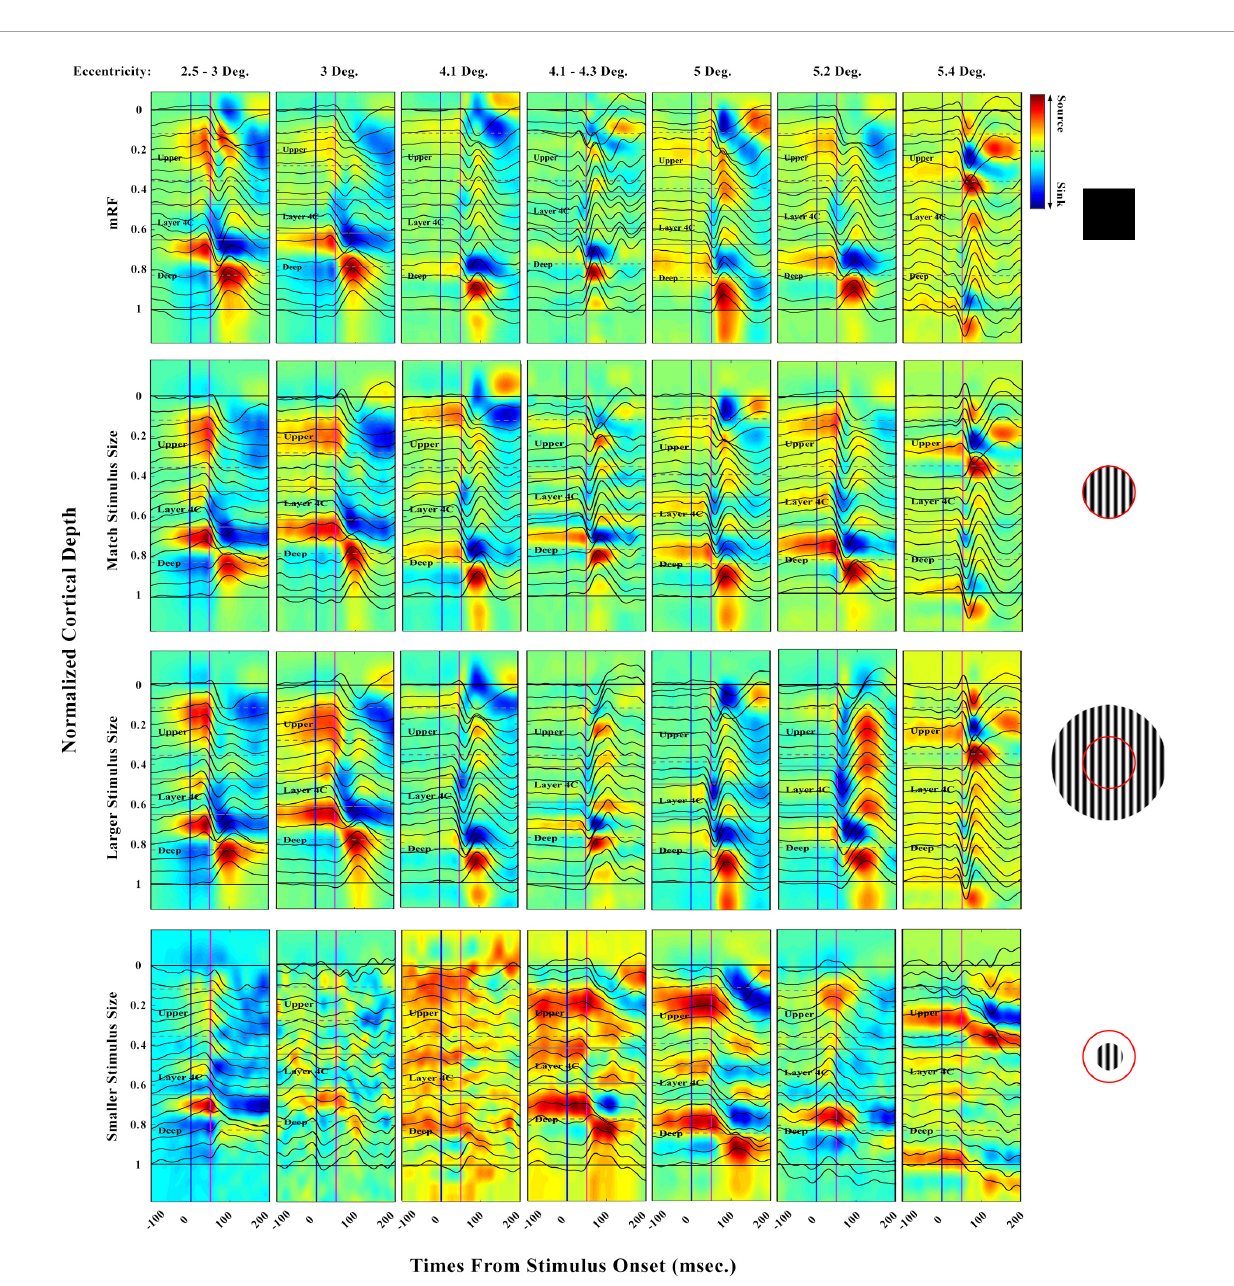
FIGURE3 Laminar evoked local field potential (LFP) profile and distribution of extracellular current sinks and sources (CSD) obtained in response to four types of stimuli: [0.5 Deg. black square, match, larger, and smaller stimulus size with respect to receptive field (RF)]. The (first row) shows the response of the LFPs and CSDs to the black square stimulus of 0.5 degrees in different eccentricities. The (second row) shows the response to the stimulus with an equal size to RF. In the (third row) , the response to the stimuli with a larger size, and in the last row, the response to the stimuli with a smaller size than the RF are presented. The vertical blue line refers to the onset and the pink one to 50 msec. Horizontal solid black lines indicate the boundary of the beginning and the end of the layers. The horizontal gray lines refer to the boundary of the layers. The vertical axis shows the normalized cortical depth, and the horizontal axis represents time. The time axis indicates a range of –100 to 200 milliseconds. LFP recordings were made in V1 at 2 ◦ –6 ◦ eccentricities and seven penetrations. The exact value of the eccentricity of each penetration is indicated at the top of the figure. The red circle is a schematic view of the RF. Sinks can be distinguished by blue color and sources by red. The shape color guide is placed on the left side and above the